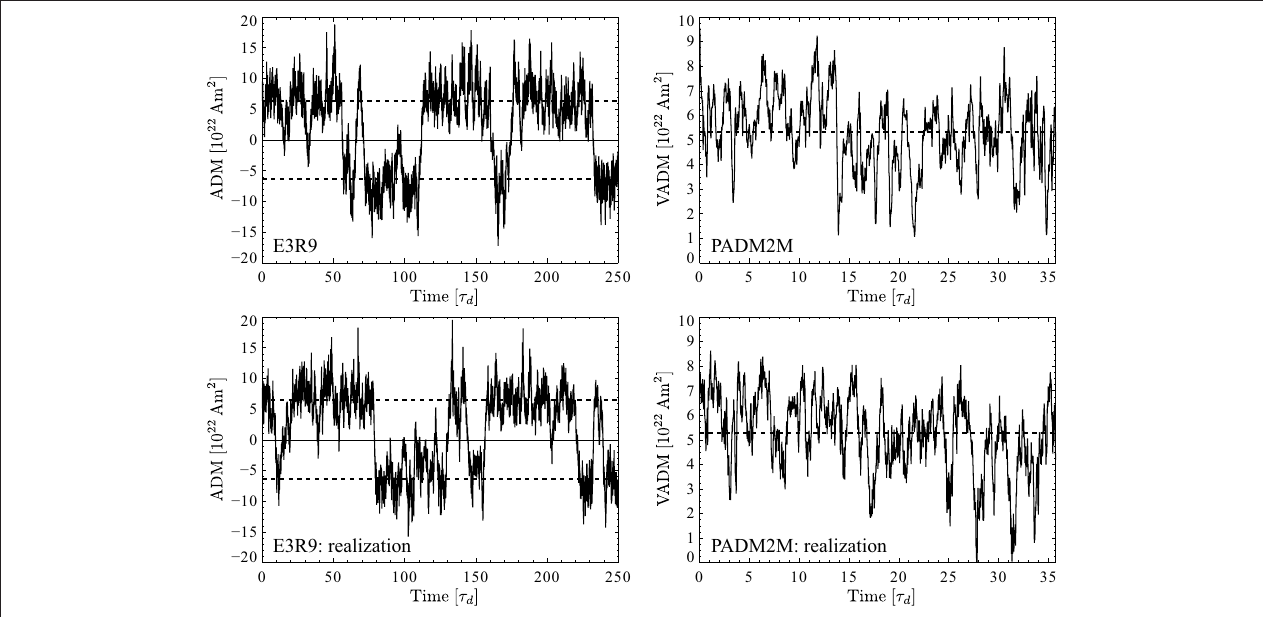
FIGURE 7 | Axial dipole moment variations for the reversing dynamo model E3R9 and for the palaeomagnetic model PADM2M (top panels) with the respective realizations of the stochastic model (bottom panels). E3R9 is shown over an interval of 250 dipole decay times τ d while PADM2M covers 2 Myr or about 36 τ d . The horizontal dashed lines mark the unsigned axial dipole moment mean values. The stochastic realizations have been started with the same initial (V)ADM values of the original time series.